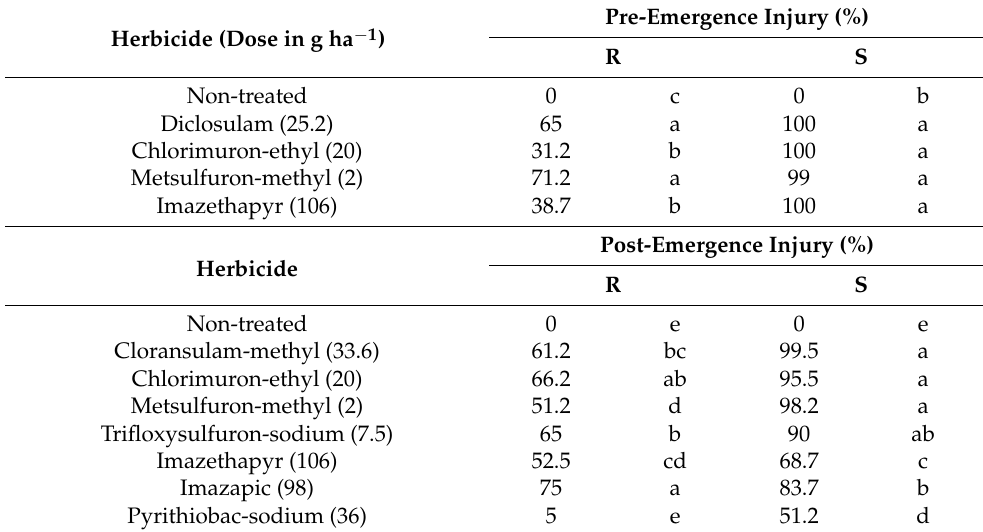
Table 1. Percentages of injury at 28 days after application (DAA) of two Erigeron sumatrensis popula- tions after the application of ALS-inhibiting herbicides in Pre- and Post-emergence. Pre-Emergence Injury (%) Herbicide (Dose in g ha − 1 ) R S Non-treated 0 Diclosulam (25.2)